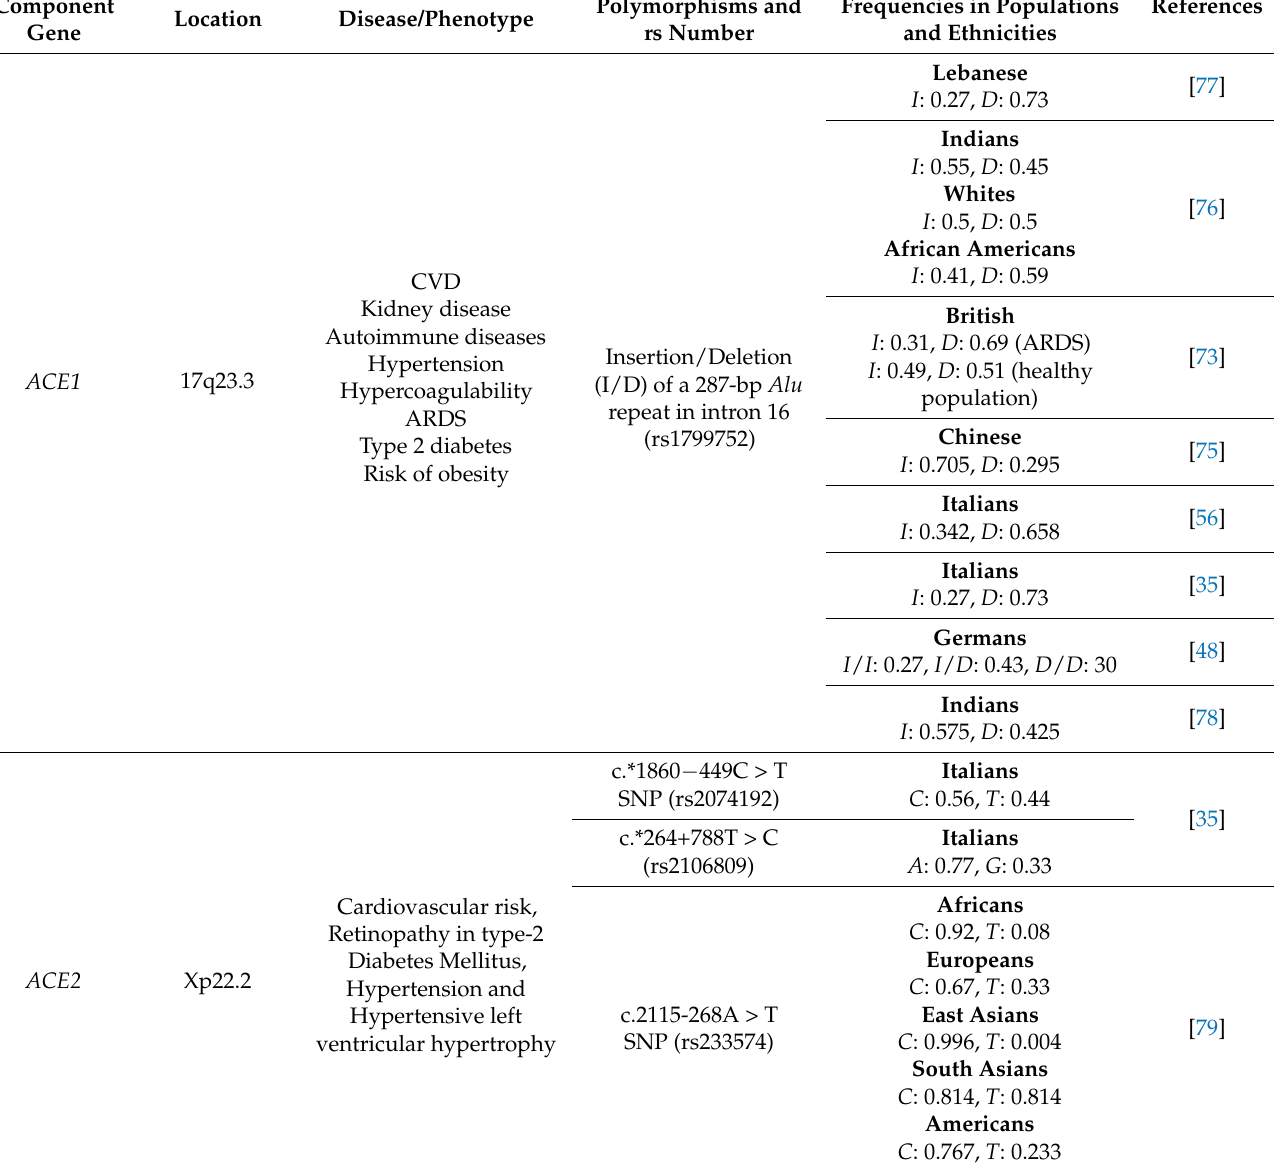
Table 1. Human gene mutations and polymorphisms of the Renin–Angiotensin System associated with COVID-19. RAS